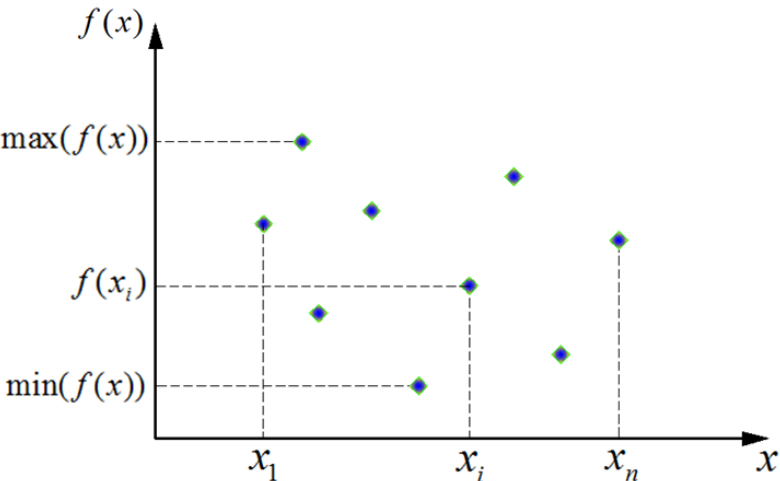
Figure 3. The schematic diagrams of dependent variables distribution in two-dimensional space. The calculation formula for the central value of the dependent variable is: where f ( x i ) is i -th dependent